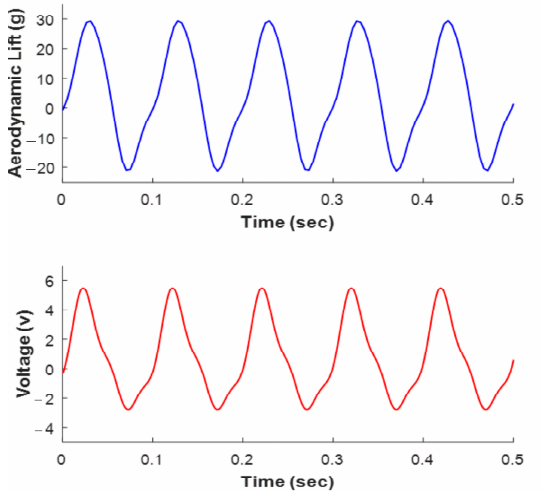
Figure 7. Lift and voltage variation versus time at 10 Hz.